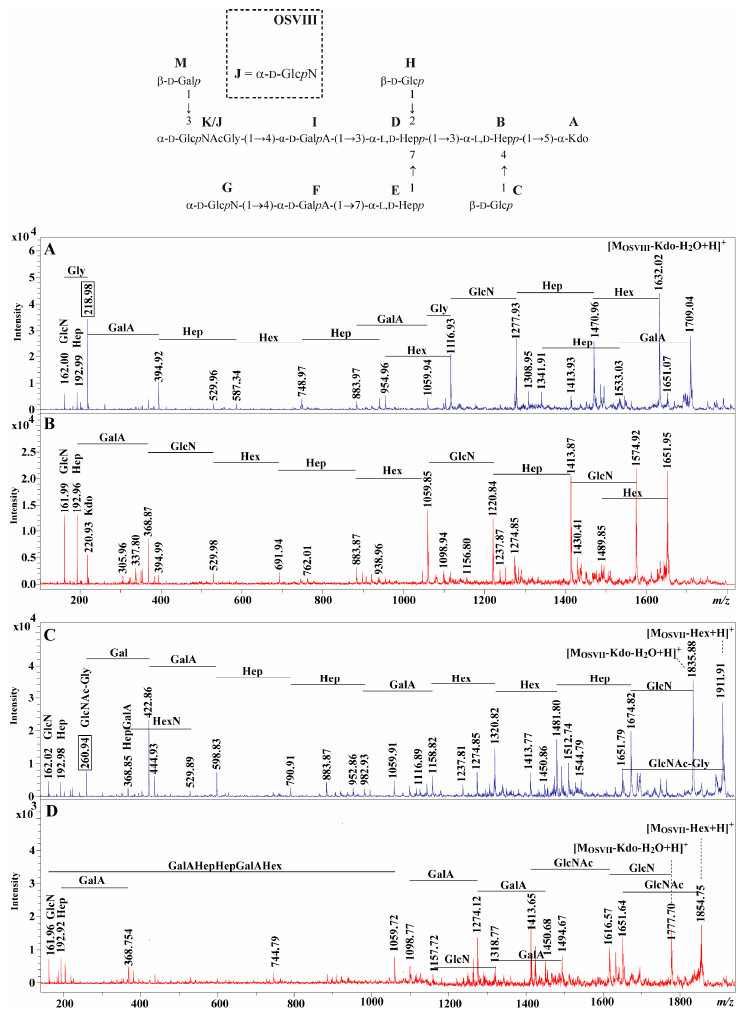
Figure 3. MALDI-TOF (matrix assisted laser desorption/ionization-time of flight) MS/MS fragmentation mass spectra of the ions ( A ) at m / z 1870.16 [M OSVIII +Gly+H] + , ( B ) at m / z 1813.15 [M OSVIII +H] + , ( C ) at m / z 2074.19 [M OSVII +Gly+H] + , and ( D ) at m / z 2017.19 [M OSVII +H] + of E. tarda EIB 202, differing in the presence of glycine.